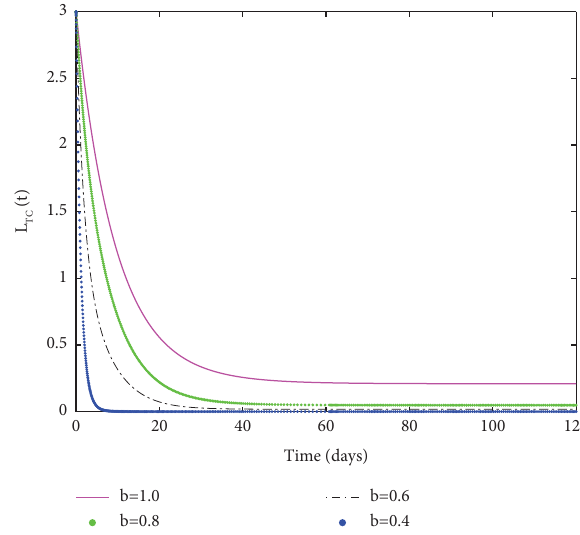
Figure 5: Behaviour of the COVID-19 asymptomatic individuals at diferent values of b .